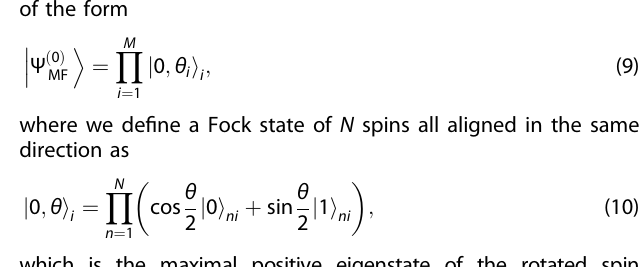
x , z , for the clarity of the fi